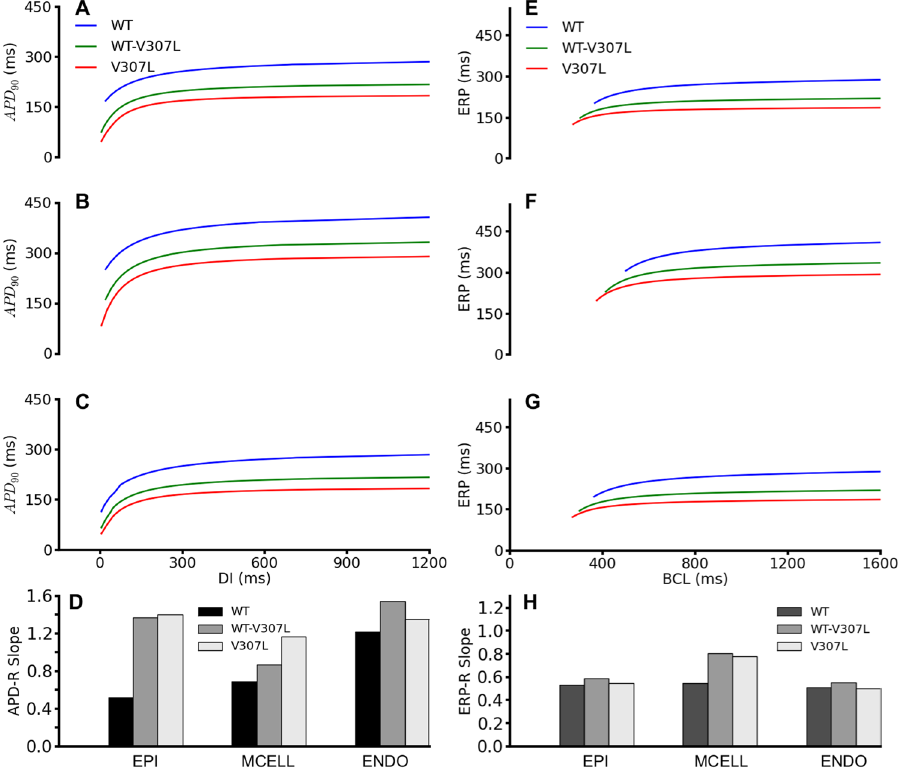
Figure 3. Restitution curves for APD and ERP. APD 90 restitution curves for EPI ( A ), MIDDLE ( B ), and ENDO ( C ) cells in WT (red), WT-V307L (green), and V307L (red) conditions, with corresponding maximal slope of APD restitution ( D ). ERP restitution curves for EPI ( E ), MIDDLE ( F ), and ENDO ( G ) cells in WT (red), WT- V307L (green), and V307L (red) conditions, with corresponding maximal slope of ERP restitution ( H